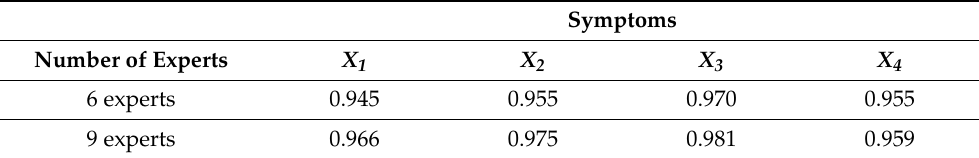
Table 5. Consistency ratio (CR) for the second parameter Y 2